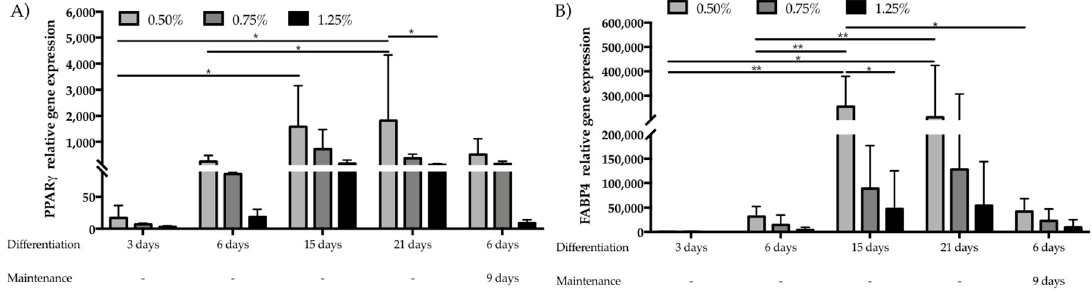
Figure 3. Relative expression of ( A ) PPAR γ and ( B ) FABP4 genes in human adipose-derived stem cells within gellan gum hydrogel particles with different amounts of polymer (0.5%, 0.75% and 1.25%) cultured in adipogenic induction medium for 3, 6, 15 and 21 days and for six days plus maintenance medium for 9 days. * p < 0.05 and ** p < 0.01.